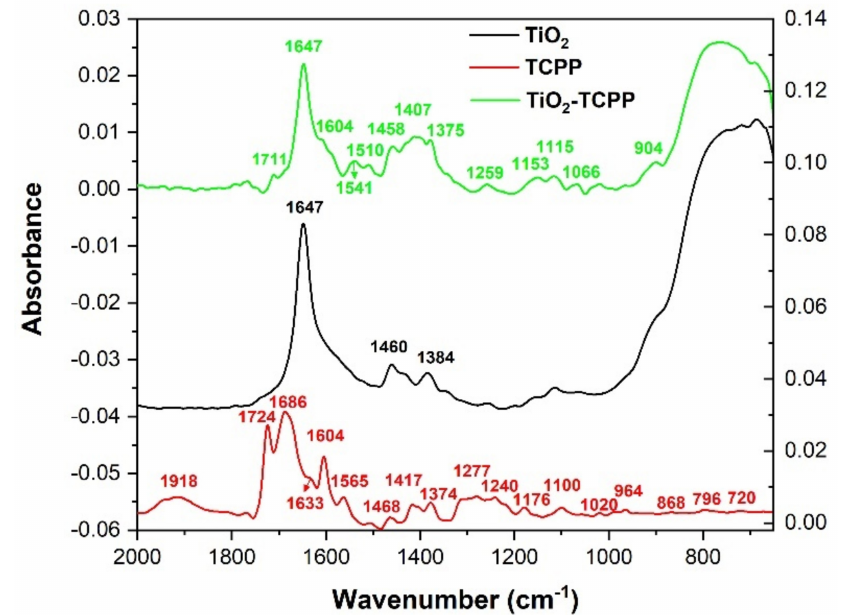
Figure 6. FTIR–ATR spectra of TiO 2 NPs, TCPP, and TiO 2 NPs loaded with TCPP. Left axis corre- sponds to the TiO 2 -TCPP spectrum, while right axis corresponds to TiO 2 and TCPP spectra. The TiO 2 spectrum is vertically translated. Table 5. Experimental and calculated frequencies for